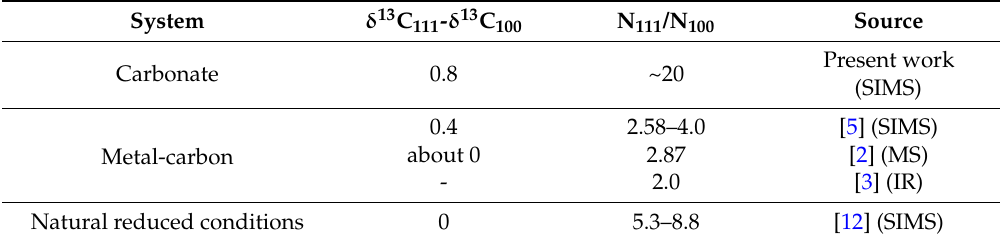
Table 2. Summary of available data on compositional difference between sectors of growth of octahedra and other crystallographic faces within synthetic diamond single crystals. Methods of data collecting are emphasized: IR—infra-red spectroscopy; MS—convenient bulk combustion with mass-spectrometry; SIMS—secondary ion